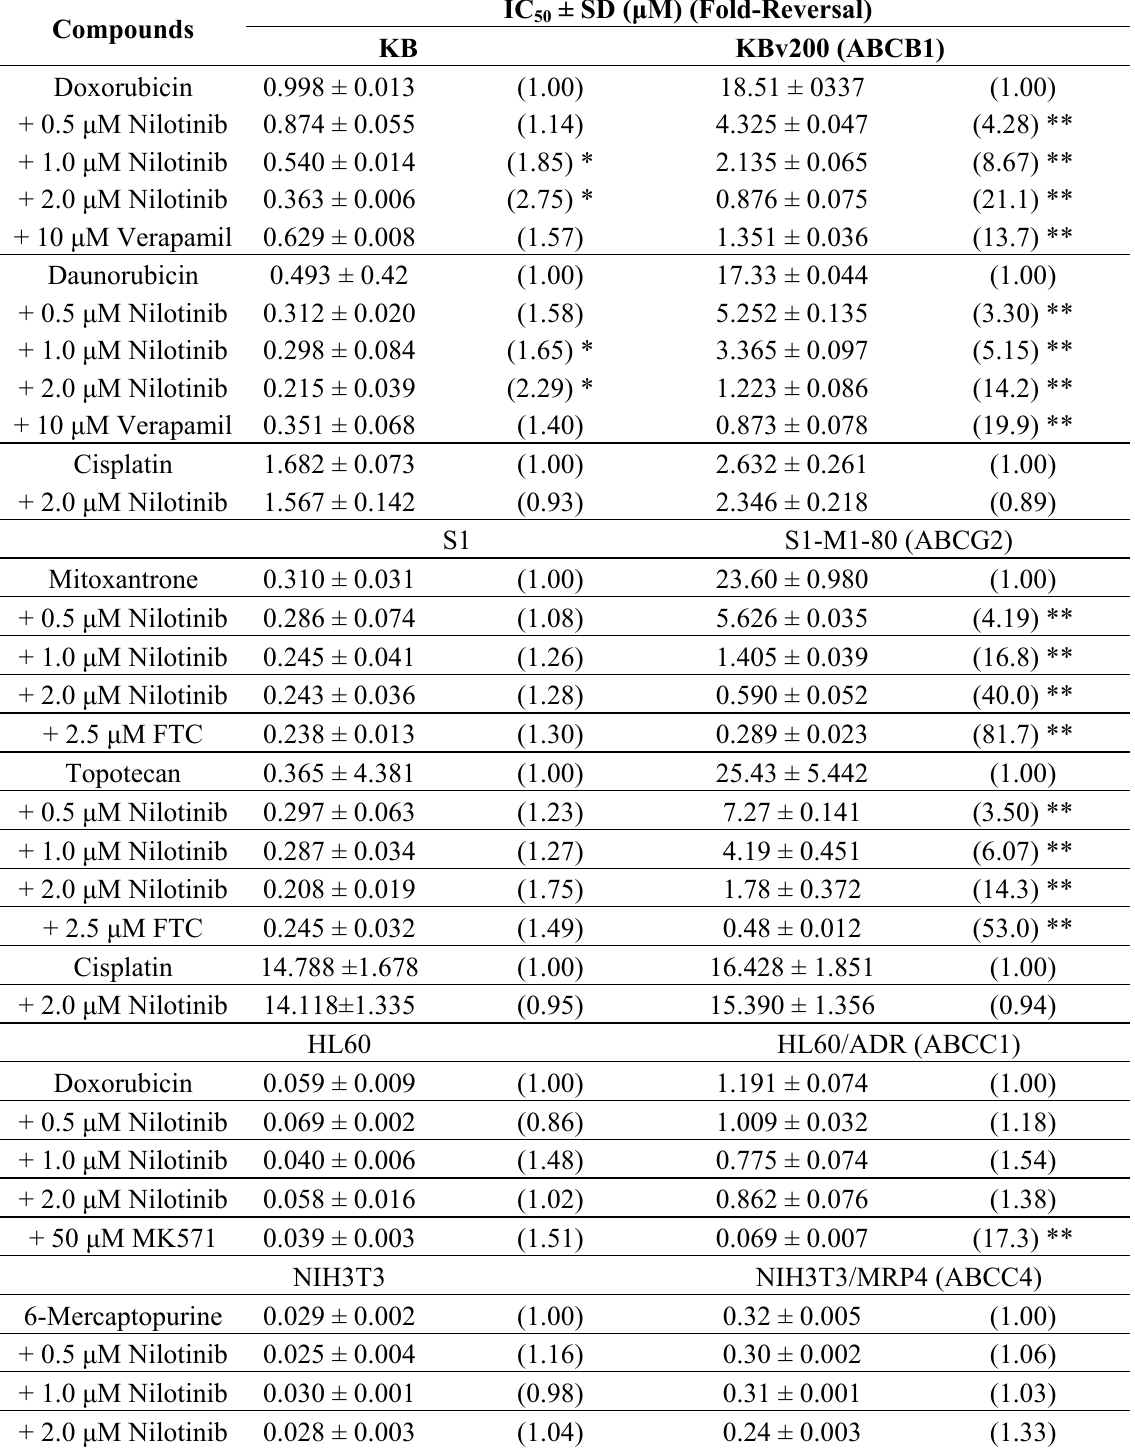
Table 1. Effect of nilotinib on reversing ABCB1-, ABCG2-, ABCC1- and ABCC4- mediated drug